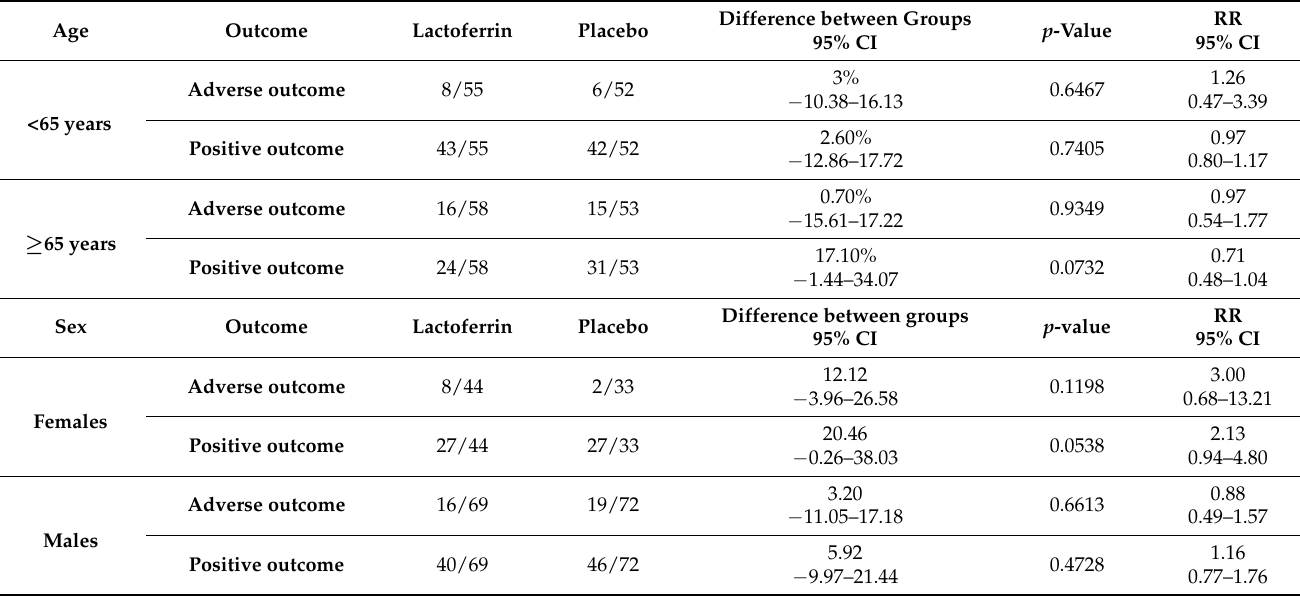
Table 5. Lactoferrin effectiveness in driving disease evolution towards primary endpoints according to age subgroup and gender.